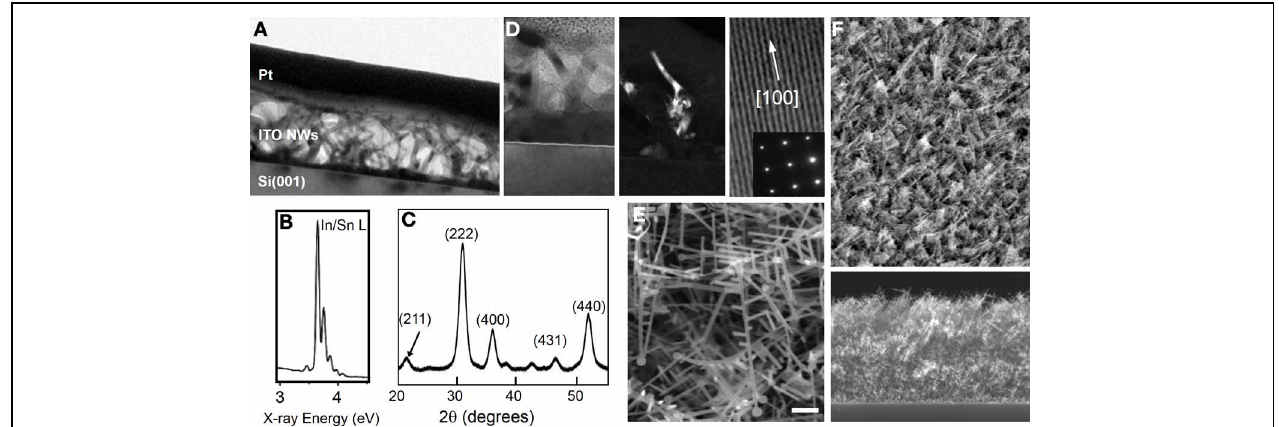
FIGURE 4 | (A) TEM image of a region of the ITO NW layer at early stages of NW growth showing the porous nature of the deposit stemming from the seed layer on the Si surface. (B) Large area EDX spectrum acquired after early stages of NW growth showing the In and Sn L-edge lines, O and Si substrate lines of (In 1 . 875 Sn 0 . 125 )O 3 . (C) XRD pattern for early stages of NW growth indexed to the (In 1 . 875 Sn 0 . 125 )O 3